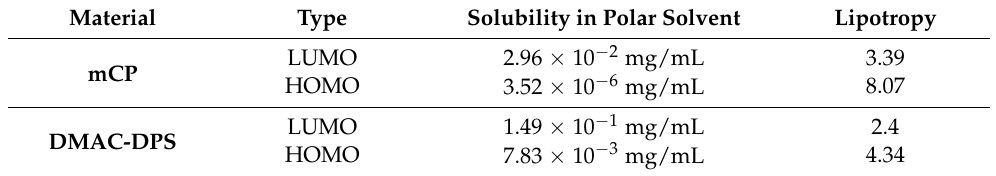
Table 2. The solubility in polar solvents and lipophilicity of LUMO and HOMO molecular groups. Material